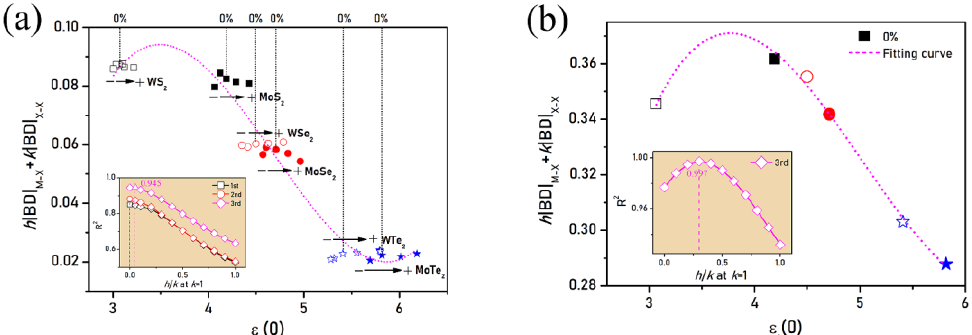
Figure 9. Results of h|BD| M-X +k|BD| X-X vs. ε 1 (0) of the MX 2 bilayer structures ( a ) under biaxial strain range of [ − 4%; +4%] and ( b ) under no strain at their maximal fitting coefficient of determination R 2 . Inset in ( a ) depicts the first-, second- and third-order fittings of R 2 vs. h/k. Inset in ( b ) depicts the third-order fitting of R 2 vs. h/k ratio. Arrows in between symbols “−” and “+” in (a) are used to represent the evolution from the biaxial compressive ( − 4%, − 2%) strains to the tensile (+2%, +4%) ones.